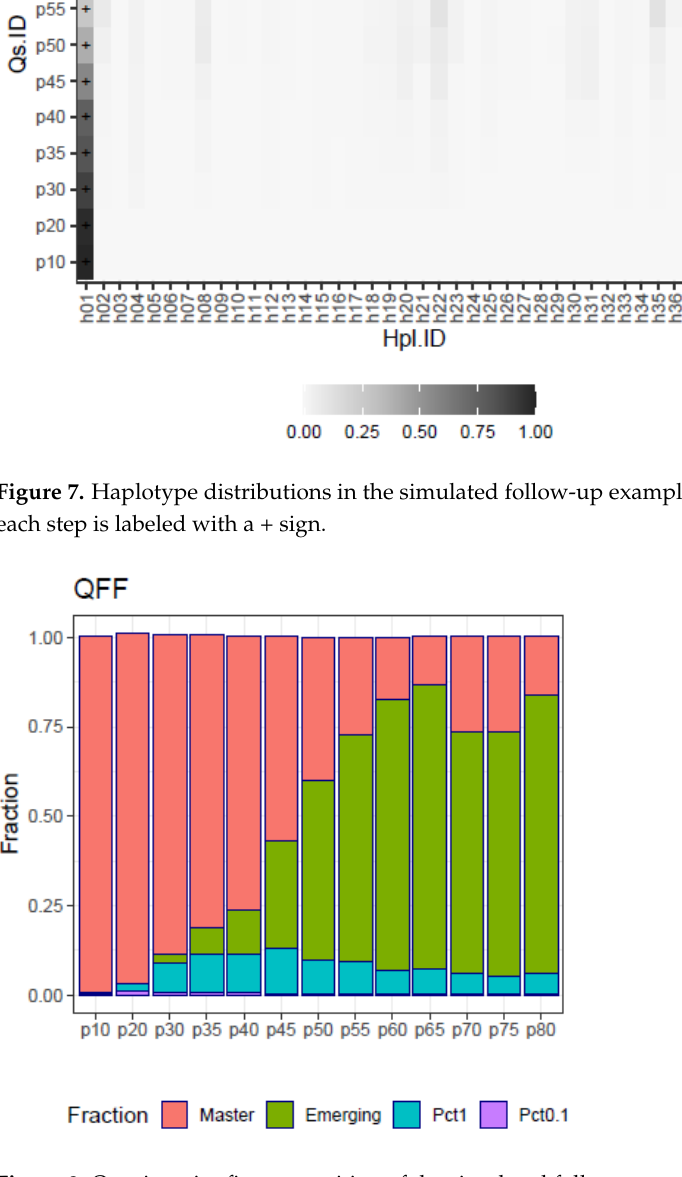
Figure 8. Quasispecies fitness partition of the simulated